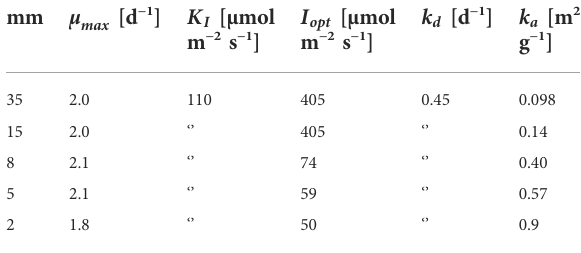
TABLE 1 Fitted parameters for data at all reactor